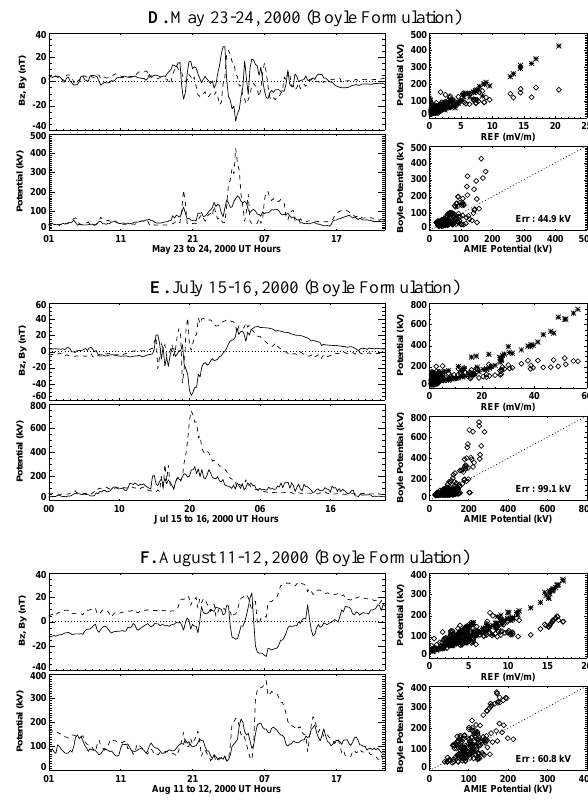
Fig. 1. The upper-left plot in each cluster shows the IMF B z (solid) and IMF B y (dashed). The lower-left plot shows the ionospheric cross polar cap potential (CPCP) as specified by AMIE (solid) and estimated from the Boyle et al. (1997) formulation (dashed). The upper-right plot shows the Boyle et al. (1997) (stars) and AMIE CPCP (diamonds) versus the reconnection electric field. The bottom-right plot show the AMIE CPCP versus the Boyle et al. (1997) formulation potential.